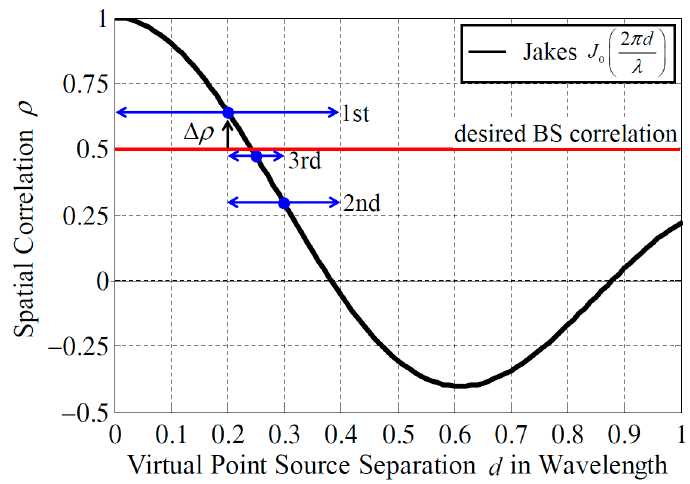
Figure 4. Virtual point source separation vs. desired BS correlation.